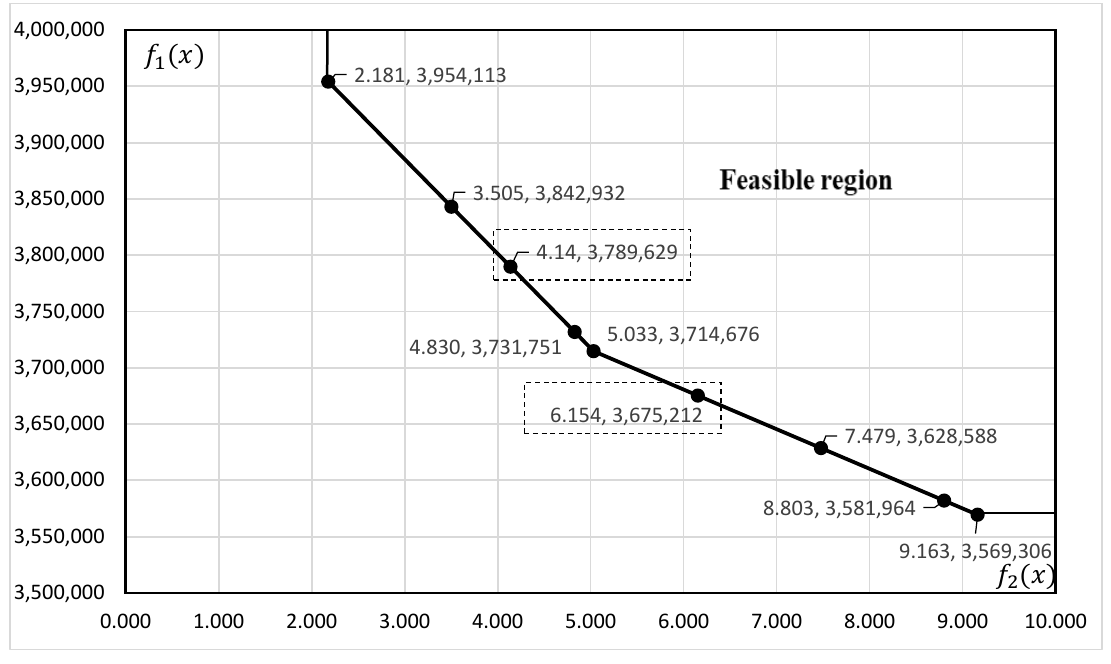
Figure 2. The result from the TH fuzzy approach.